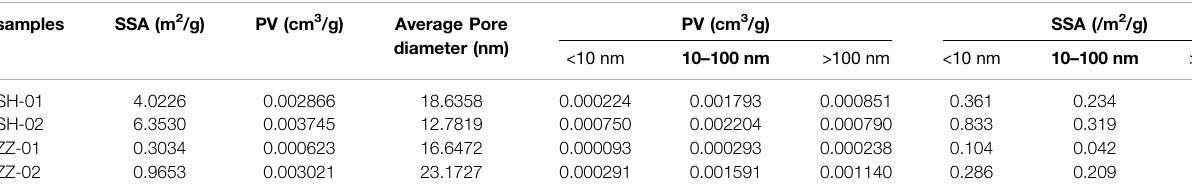
TABLE 3 | Porosity test results of No.3 coal seam.